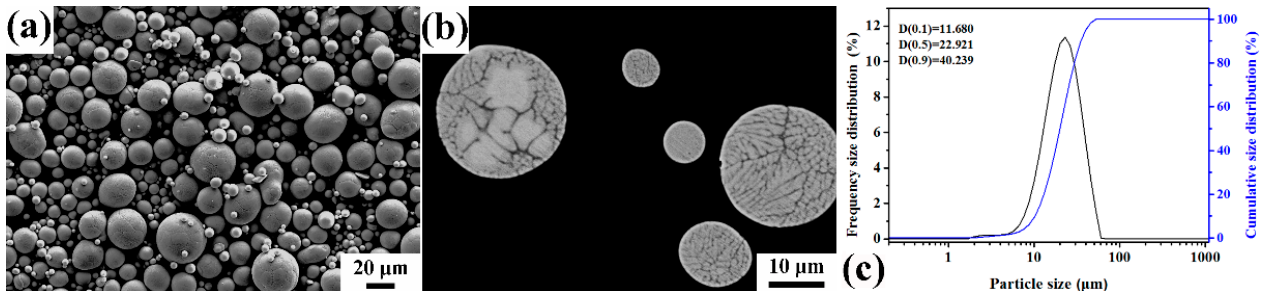
Figure 1. ( a , b ) SEM images of pre-alloyed powder; ( c ) particle size